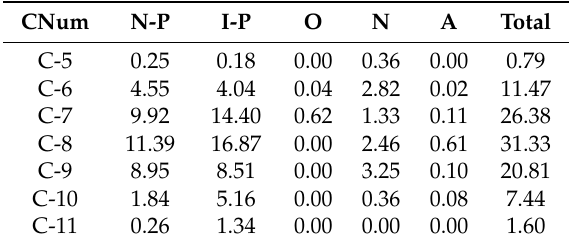
Table 4. The PIONA composition of the light naphtha raw material above 75 ◦ C.